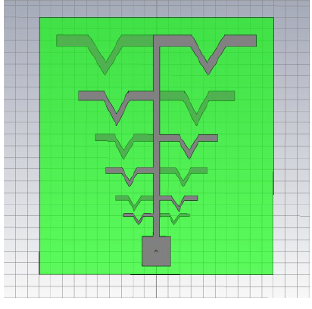
Figure 3. LPKFA with flare angle 30°.